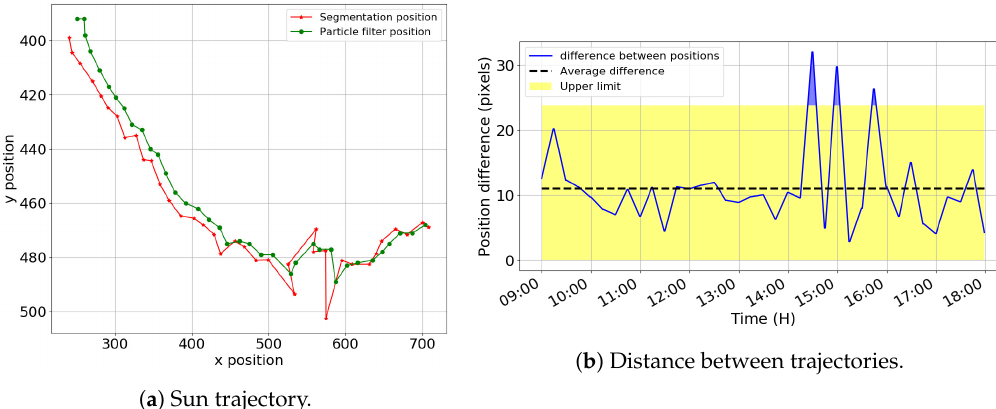
Figure 17. Sun trajectory and distance between trajectories.